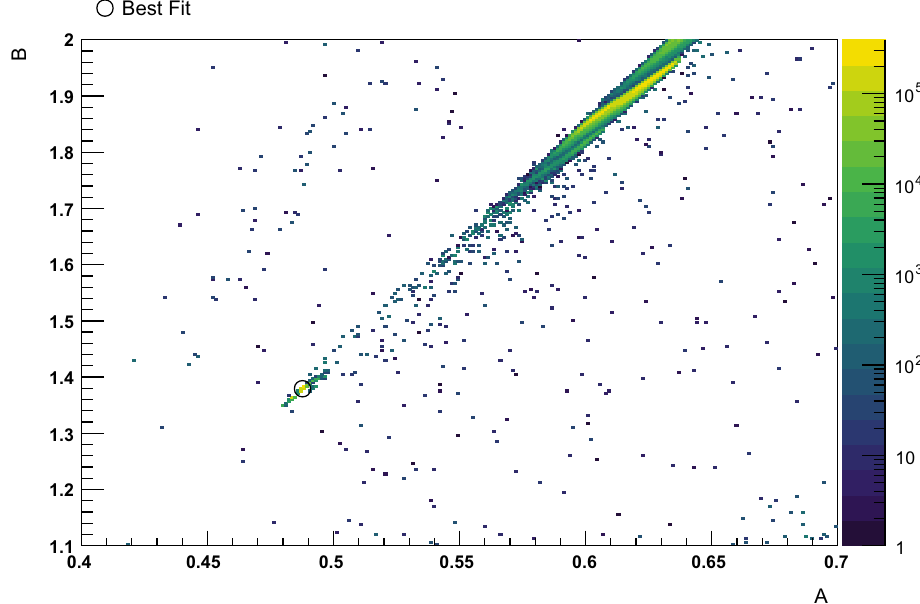
Fig. 6 Probability density of the ABC fit as a function of the B and A parameters. The legend shows the probability scale in arbitrary units